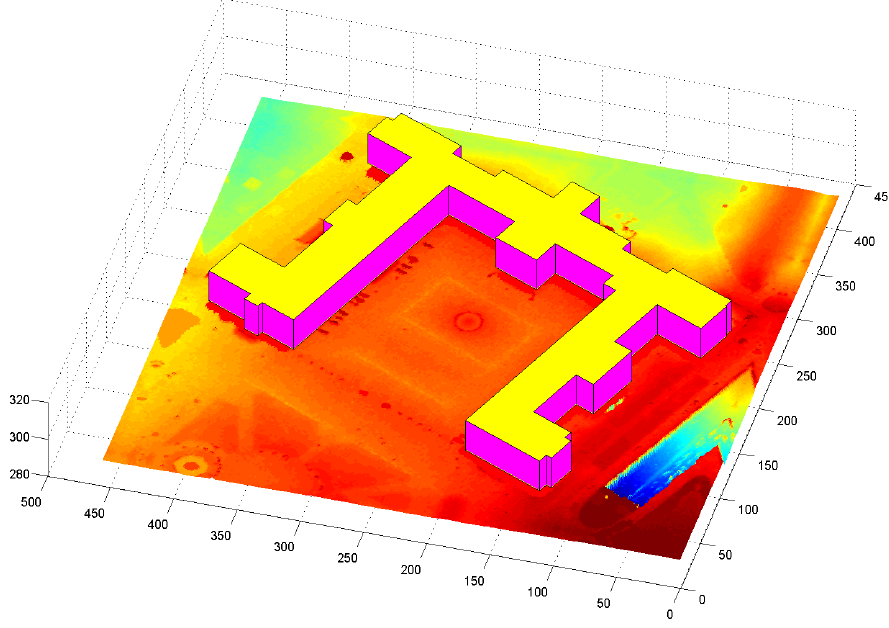
Figure 14. LOD1—Prismatic Model of New Castle